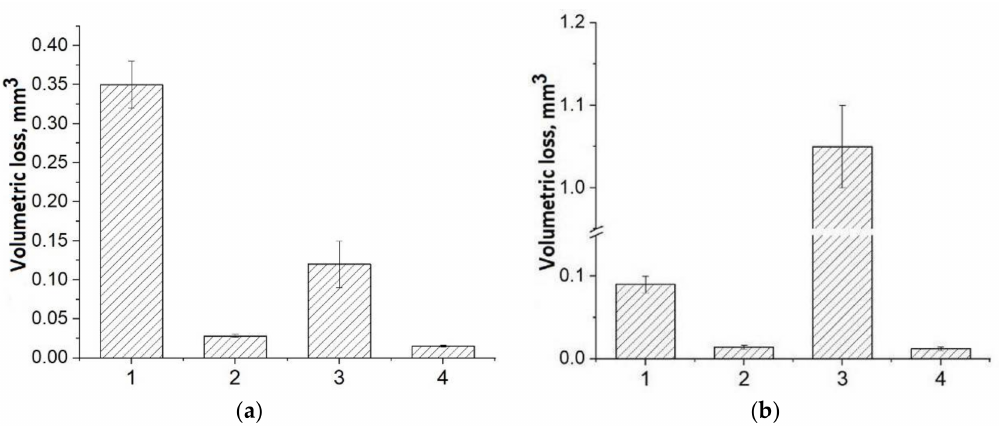
Figure 4. Volumetric wear: On ( a ) the metal counterpart and ( b ) on the ceramic counterpart (1–PEEK, 2–PEEK + 10% PTFE, 3–PEEK + 10% CF, 4–PEEK + 10% PTFE + 10% CF).